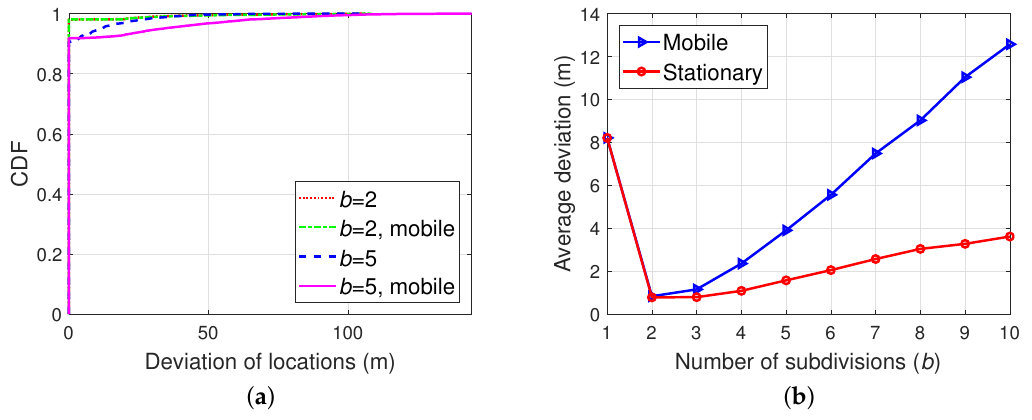
Figure 8. Comparison: ( a ) CDF of deviation of retrieved locations with different subdivisions; ( b ) Average deviation of retrieved locations with different subdivisions.